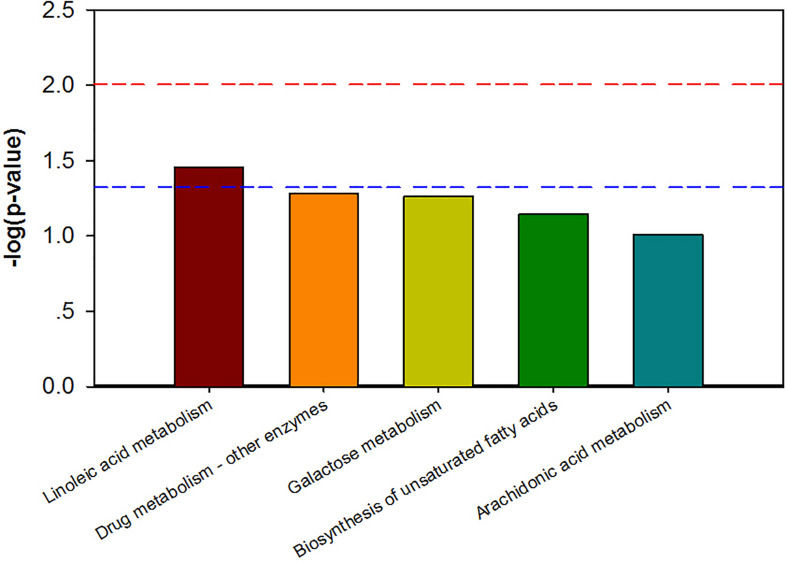
The KEGG pathway enrichment of overall differential metabolites from the control (CON) and pedal peptide-type neuropeptide injected (PDP) groups. Horizontal axis for enriched pathway; vertical axis for the significance level of pathway enrichment. Above the red and blue dashed lines represents p < 0.01 and p < 0.05.